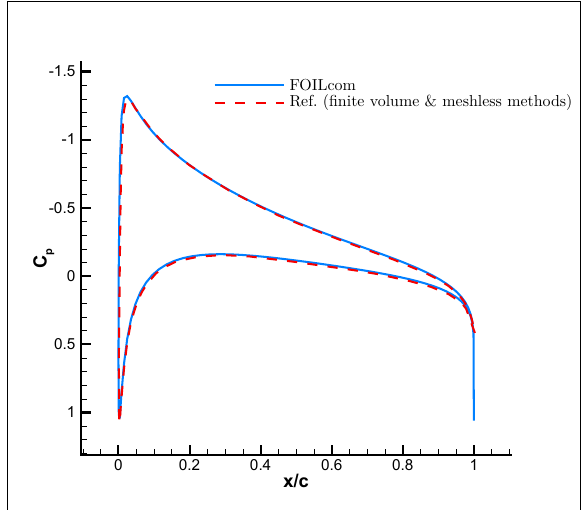
Figure 13. The pressure coefficient distribution. Comparison of FOILcom result and the one from Reference [23].